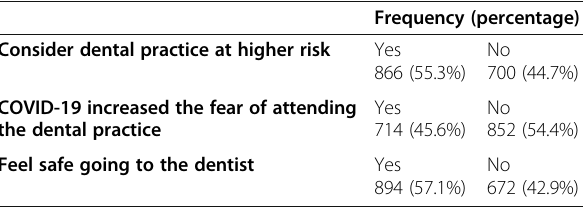
Table 2 Frequencies and percentages of replies to perceived risk and fear about attending dental practice Frequency